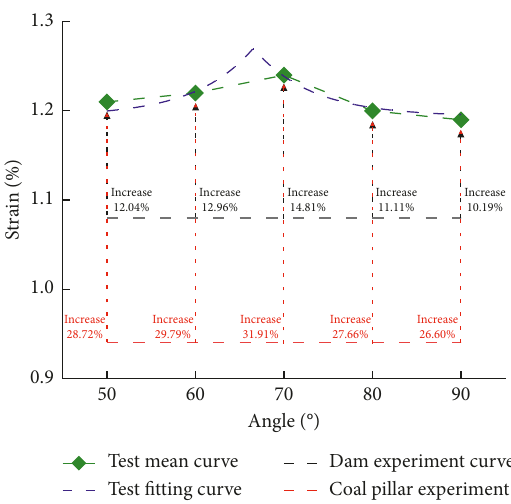
Figure 11: Relationship between angle and peak strain.